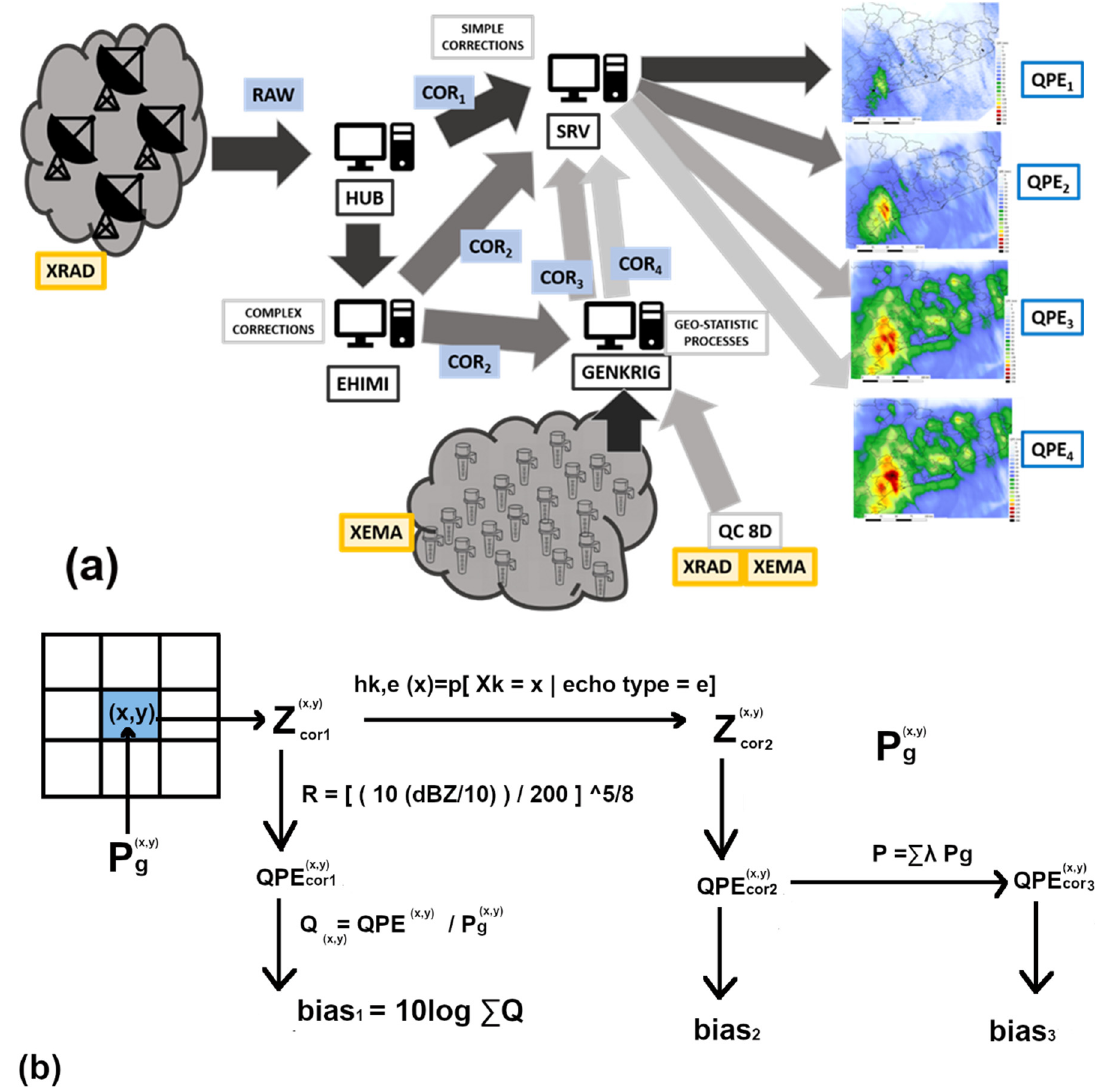
Figure 2. ( a ) Diagram of the different QPE processes. ( b ) Flow chart of the full process